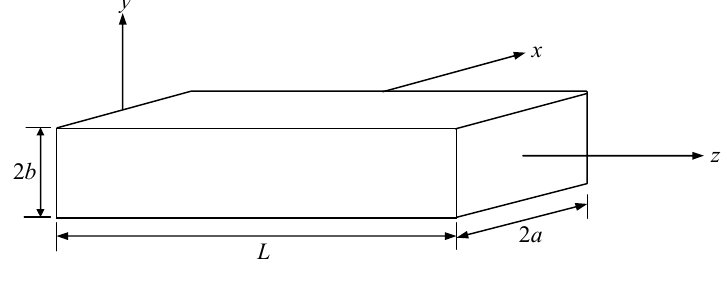
Fig. 1. A prismatic isotropic